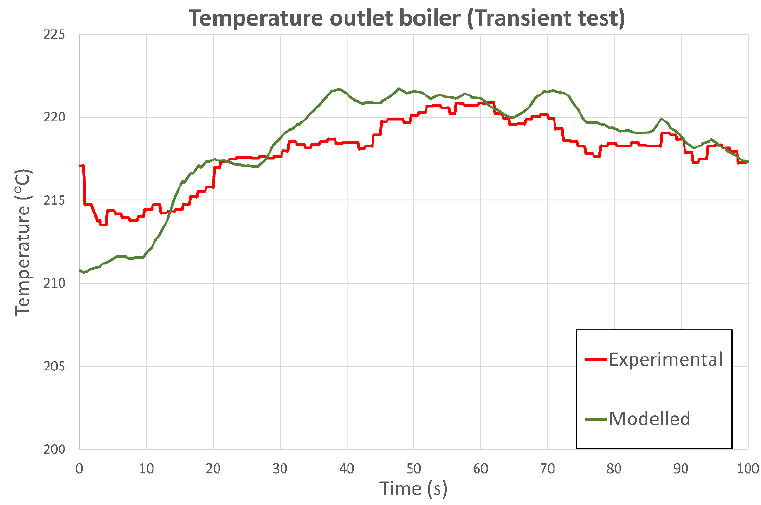
Figure 14. Validation of temperature in the boiler.